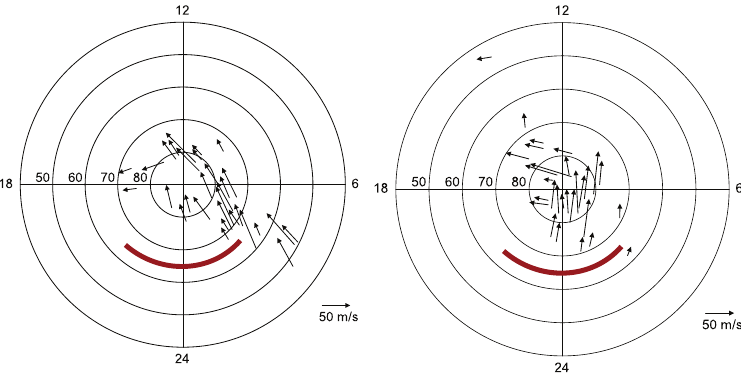
Figure 6. Directions of AGW propagation above the northern polar region for the polar day (left) and polar night (right)